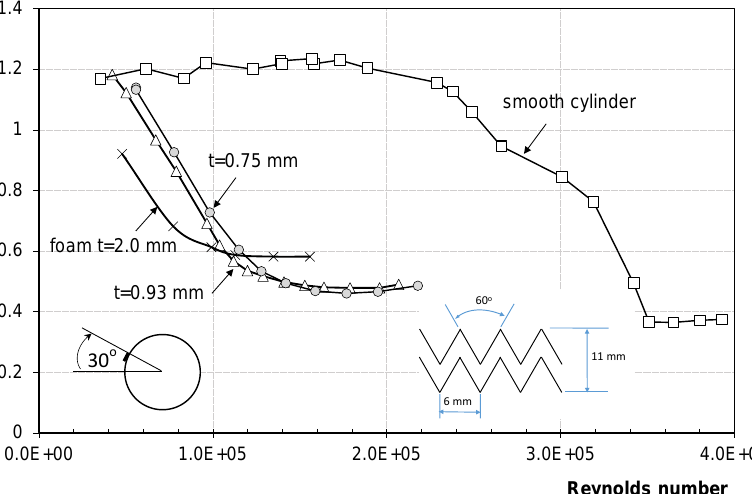
Figure 5. The effect of zigzag tape thickness on the drag coefficient of a cylinder. Tape at an azimuth position of 30 ◦ on the left and right from the leading edge. Cylinder span is 60 cm. If not indicated otherwise, the zigzag tape used during all measurements has the layout of the Teflon tape shown in the insert.